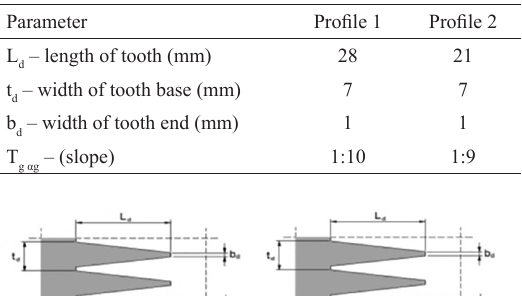
the pressing time should be six hours at about 20 degrees Celsius and relative humidity around 65% 5 .